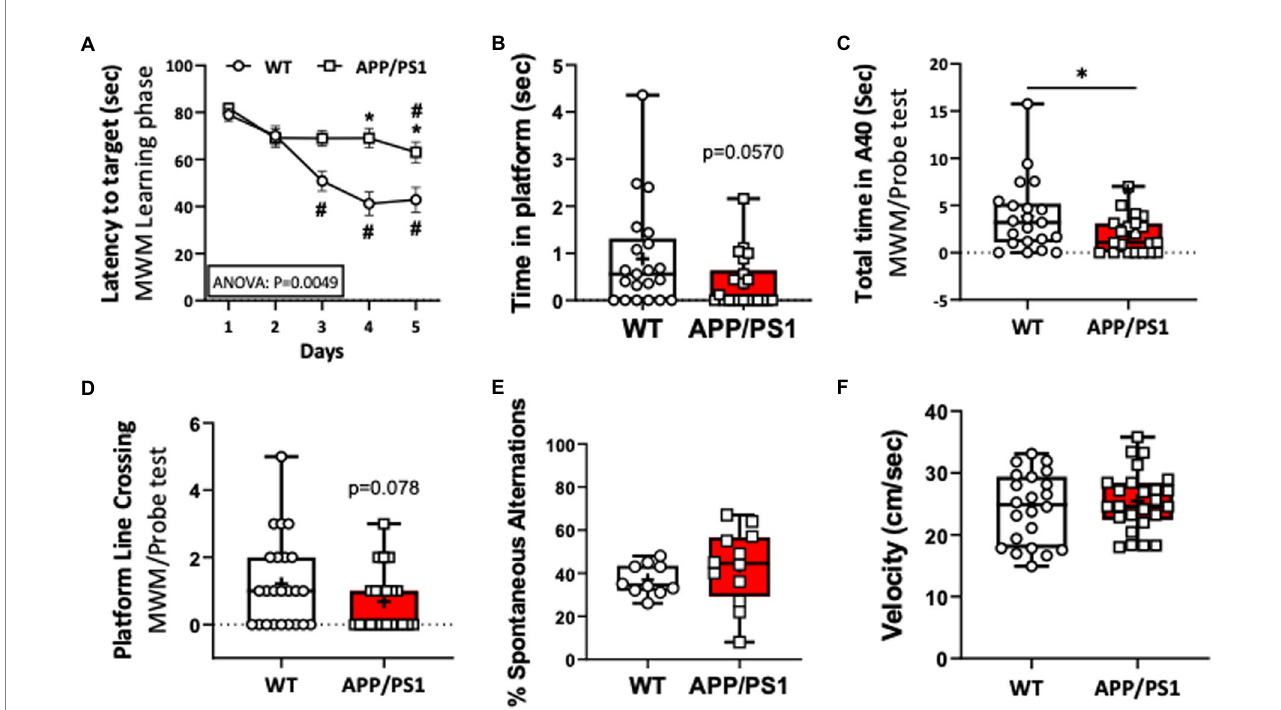
FIGURE 1 Impaired learning capacities of APP/PS1 mice in the Morris Water Maze test (MWM) compared to WT mice. (A) Increase in the latency (seconds) to reach the target reflected impaired learning capacities of APP/PS1 mice ( n =22) compared to WT mice ( n =24) in the 5 day training phase in MWM. * P < 0.05 vs WT; # P < 0.05 vs day 1. (B,C) APP/PS1 mice spent a reduced time in the platform (B) and in the target area (C) . (D) APP/PS1 mice had less platform line crossing compared to WT mice on the probe test. (E) The percent of spontaneous alternations in the Spontaneous Y-Maze test were not significantly different between groups. (F) There was no difference in velocity between WT and APP/PS1 mice during the testing. * P < 0.05 vs WT. Unpaired t test was